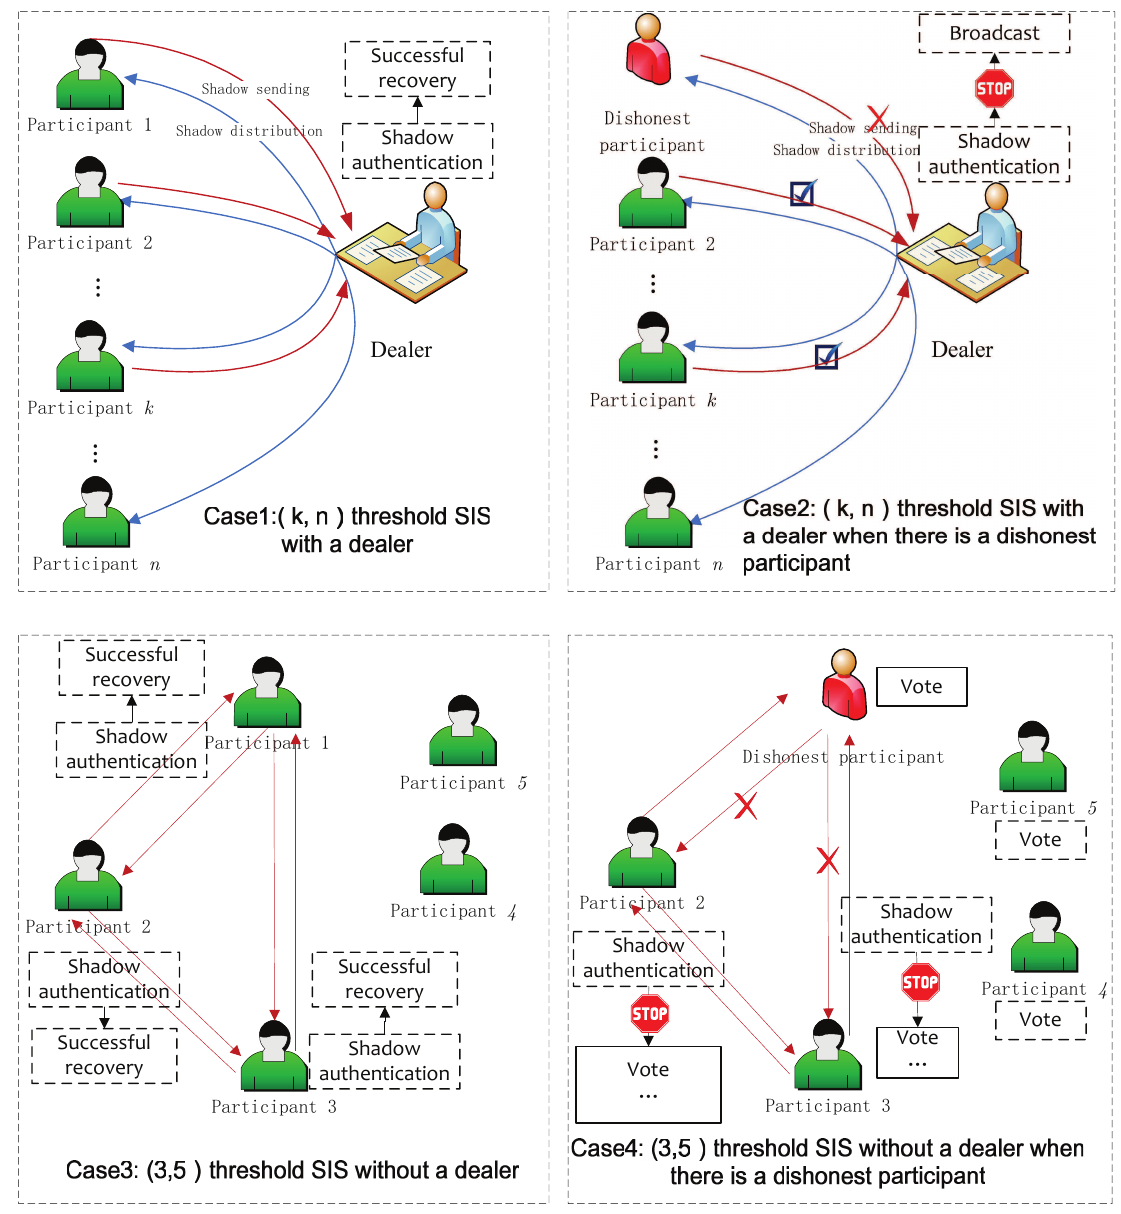
Figure 2. General application scenario regarding the ( k , n ) threshold secret image sharing (SIS) with mutual shadow authentication